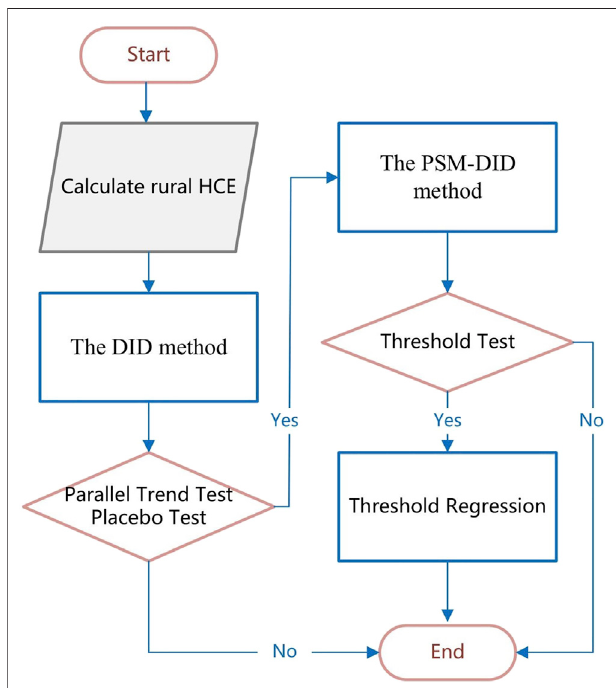
FIGURE 4 | The methodological framework